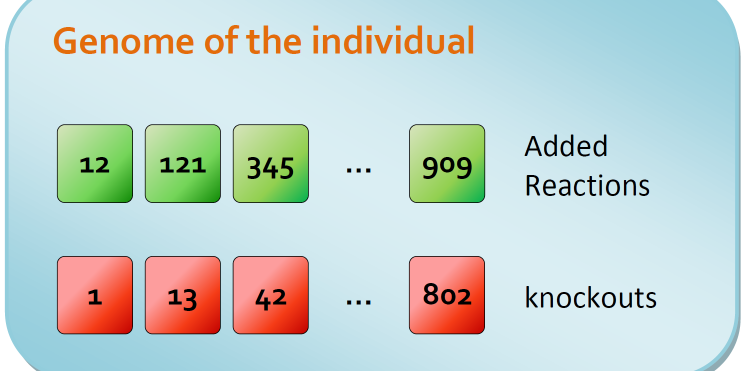
Figure 1: Representation of the genome of an individual. Green squares represent reactions that will be added to the model (numbers are the reactions indexes in the external database). The knockouts are represented by red squares (numbers are indexes of reactions in the